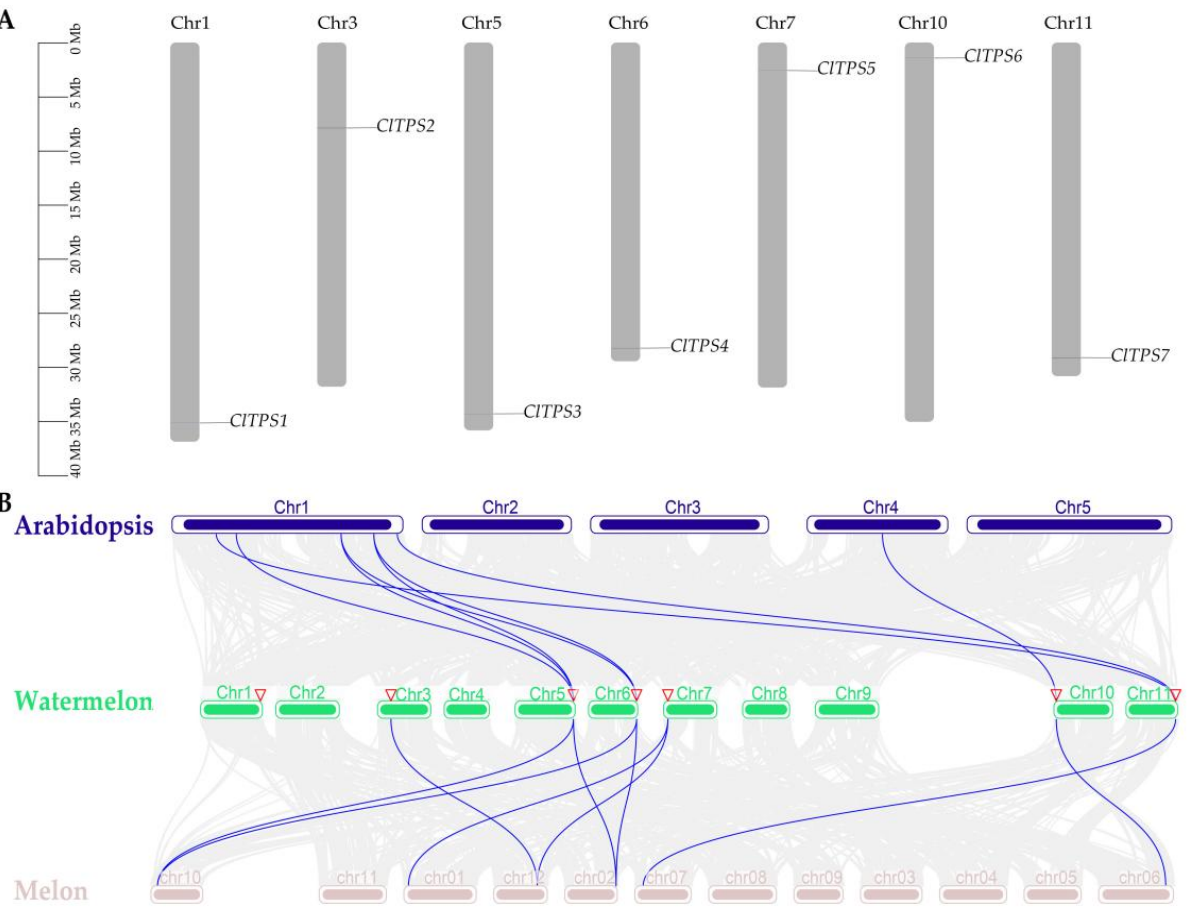
Figure 1. Chromosomal location of ClTPS genes and collinearity analysis of A. thaliana, watermelon and melon. ( A ) Chromosomal location of ClTPS genes; ( B ) collinearity analysis of A. thaliana, watermelon and melon.